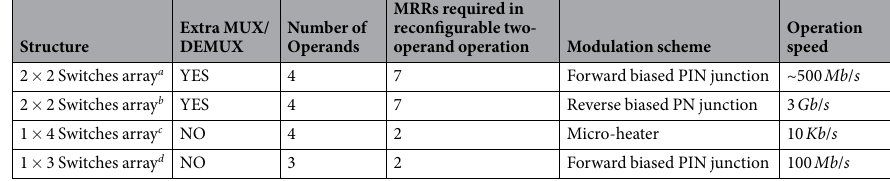
Table 1. A comparison of various reconfigurable electro-optic directed logic circuits. a Taken from ref. 43. b Taken from ref. 44. c Taken from ref. 42. d Taken from this work.